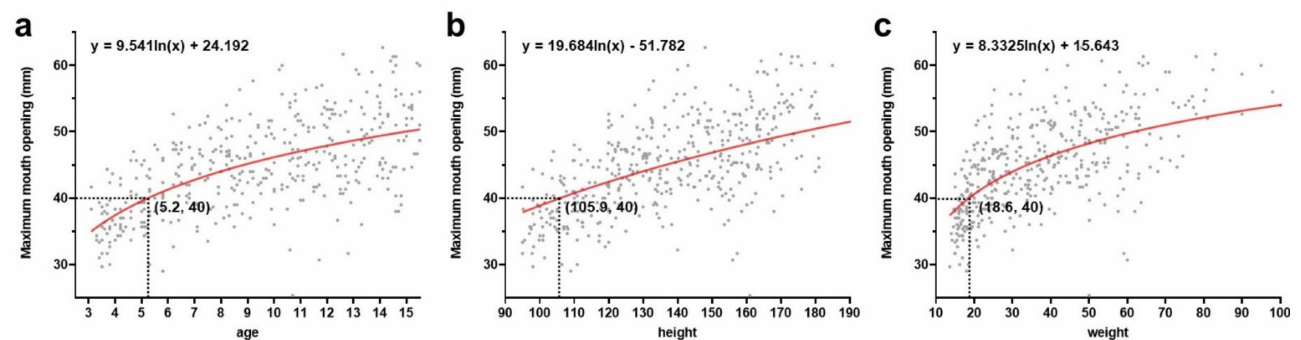
Figure 4. Logarithmic trend line of maximum mouth opening according to the studied age ( a ), height ( b ), and weight ( c ).